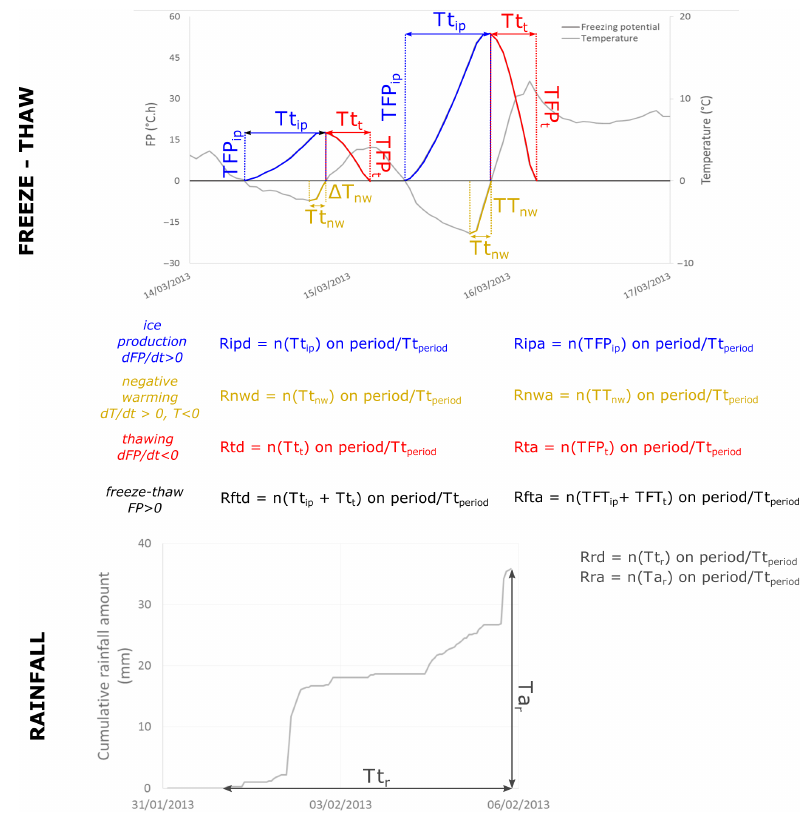
Figure 6. Description of ratios used to quantify freeze–thaw and rainfall amount and duration for each dating period of the DB1. These ratios are used for the multiple linear regression.